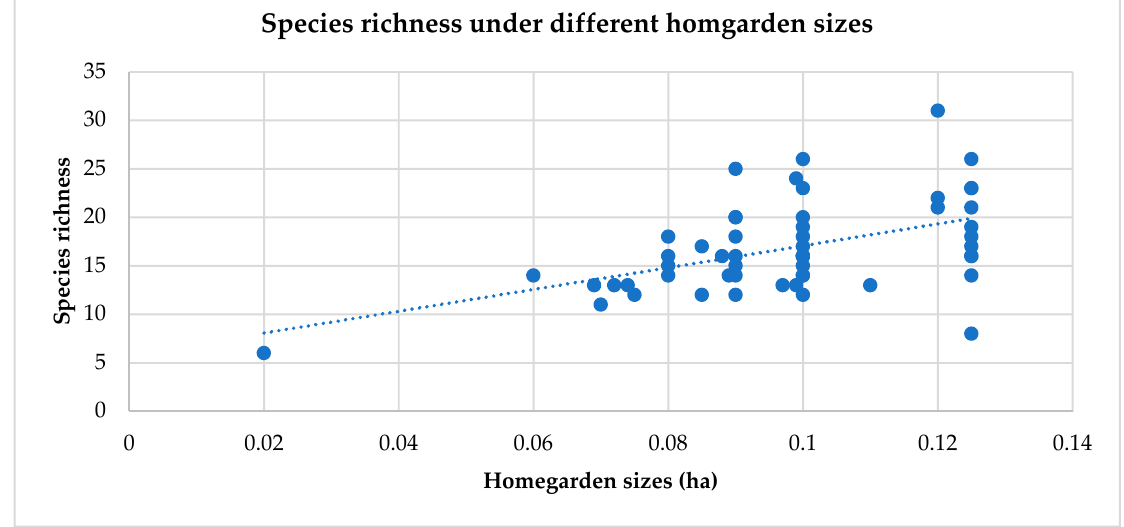
Figure 3. Relationships between homegarden size and species richness.